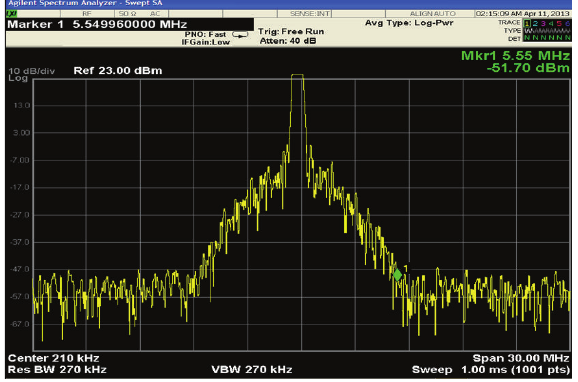
Figure 5: Exponential power distribution.